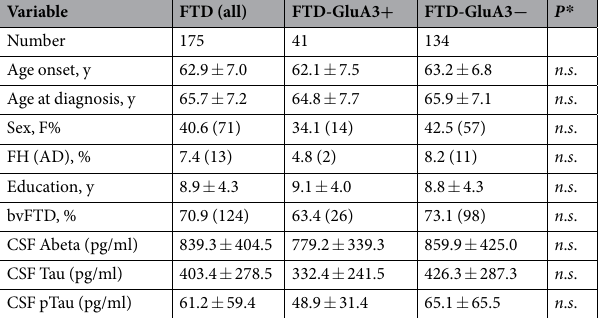
Table 1. Demographic and clinical characteristics of FTD patients according to serum anti-GluA3 antibody dosage. FTD: Frontotemporal dementia; GluA3 + : patients with anti-GluA3 antibodies; GluA3 − : patients without anti-GluA3 antibodies; y: years; F: female; FH (AD): autosomal dominant family history; bvFTD: behavioural variant FTD; CSF: cerebrospinal fluid. * P-values between GluA3 + vs. GluA3 − ; n.s.: not